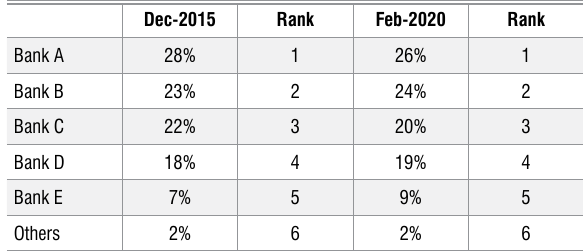
Banks’ indirect vulnerability, i.e. their percentage of equity lost due to price-mediated contagion during the -30% price